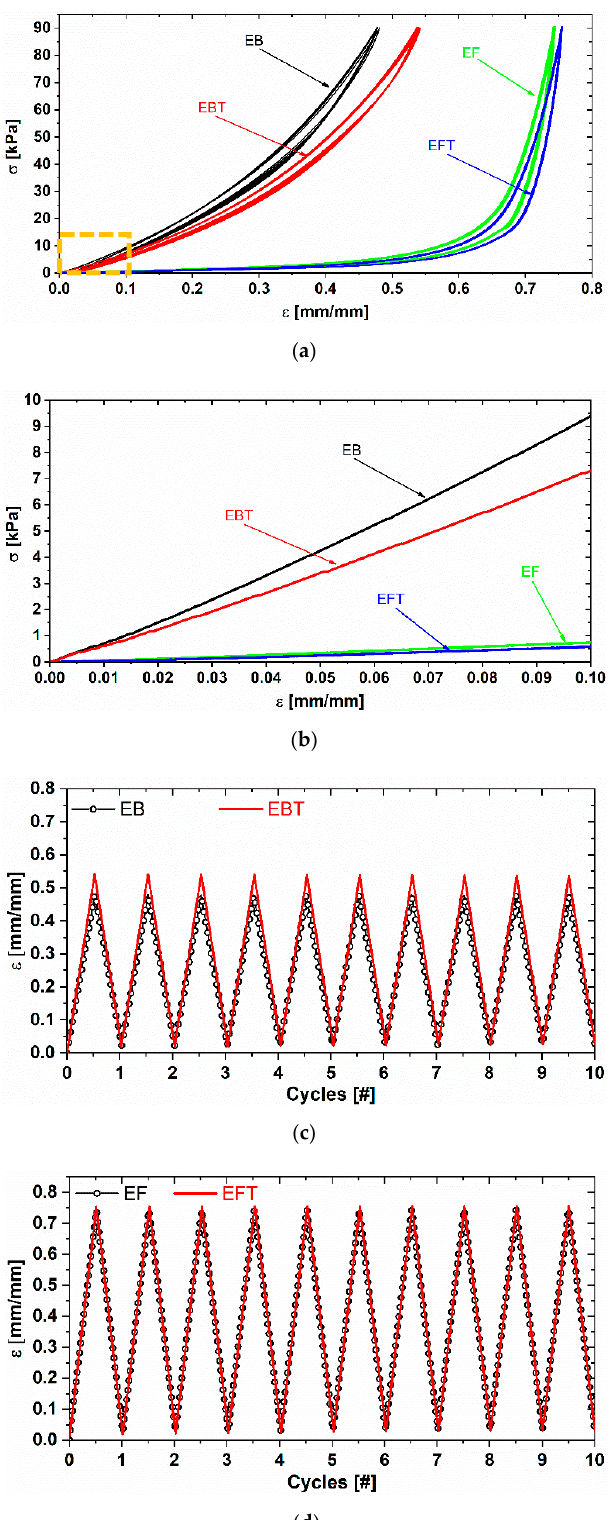
Figure 5. Stress–strain curves ( a ), magnification of the linear region of the stress–strain curves ( b ), and deformation as a function of the cyclic compressive loads ( c,d ) for different Ecoflex ® samples during cyclic compression tests.